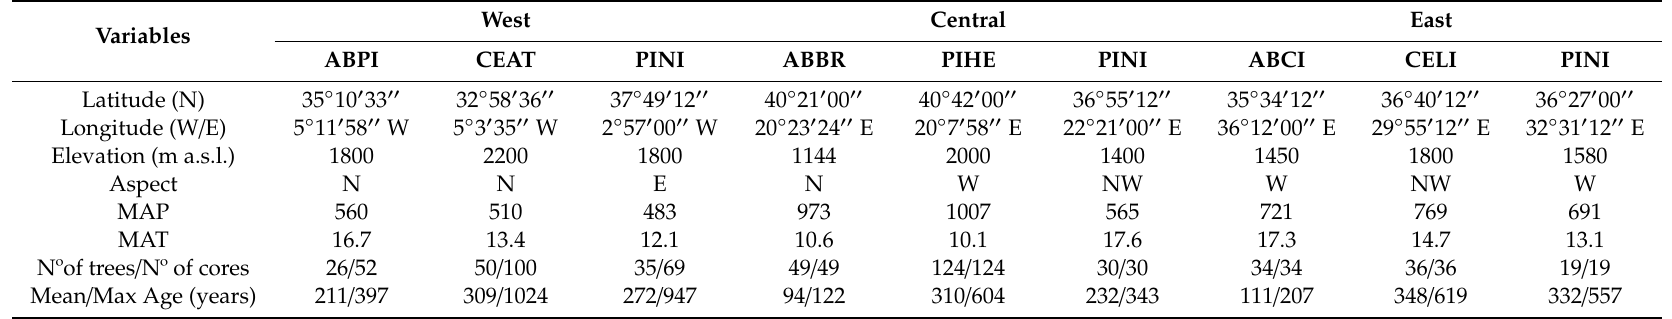
Table 1. Site features of the study forests in the Mediterranean